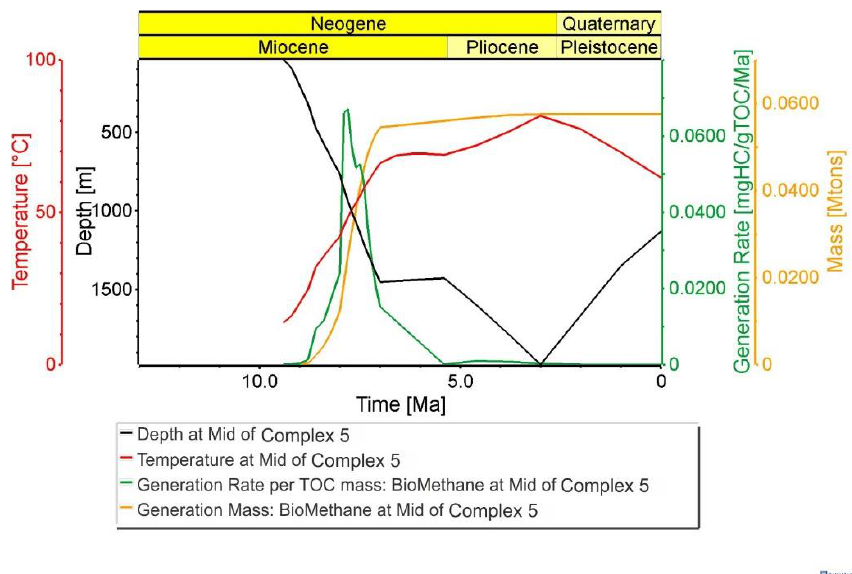
Figure 12. Progress of biomethane generation process in shallow-buried (1100-m depth) Miocene deltaic facies (Complex 5) at the front of the Carpathian Overthrust. Values of generation rate shown in Figures 12–14 reflect the mass of produced hydrocarbons and refer to the area of 700-m × 700-m calculation block of the model, and to 100-m thickness of